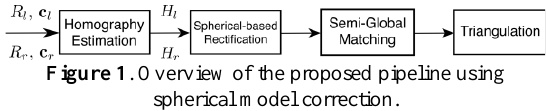
Figure 1 . Overview of the proposed pipeline using spherical model correction.